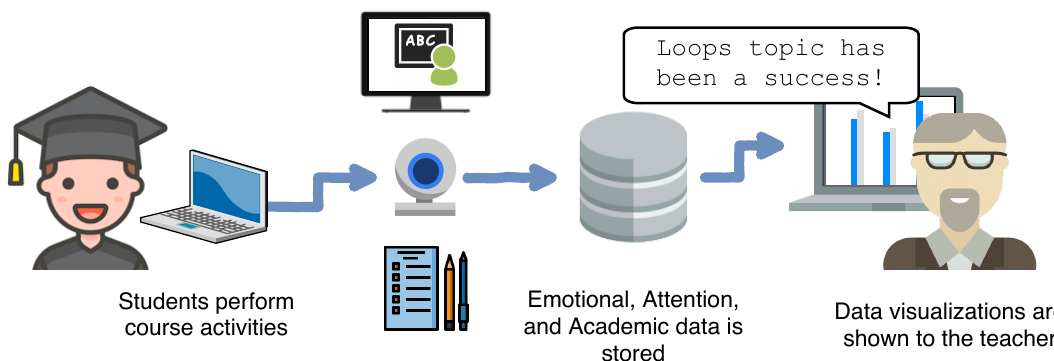
Figure 3. Academic and emotional dashboards for teachers’ case study.